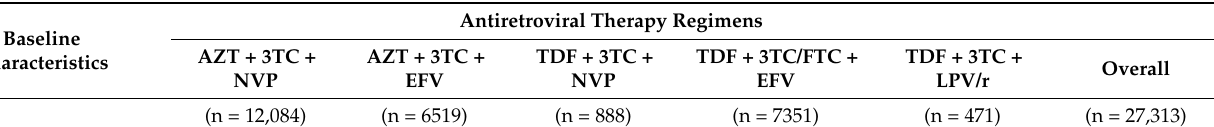
Table 1. Baseline characteristics of HIV-infected adults who received the recommended first-line antiretroviral therapy